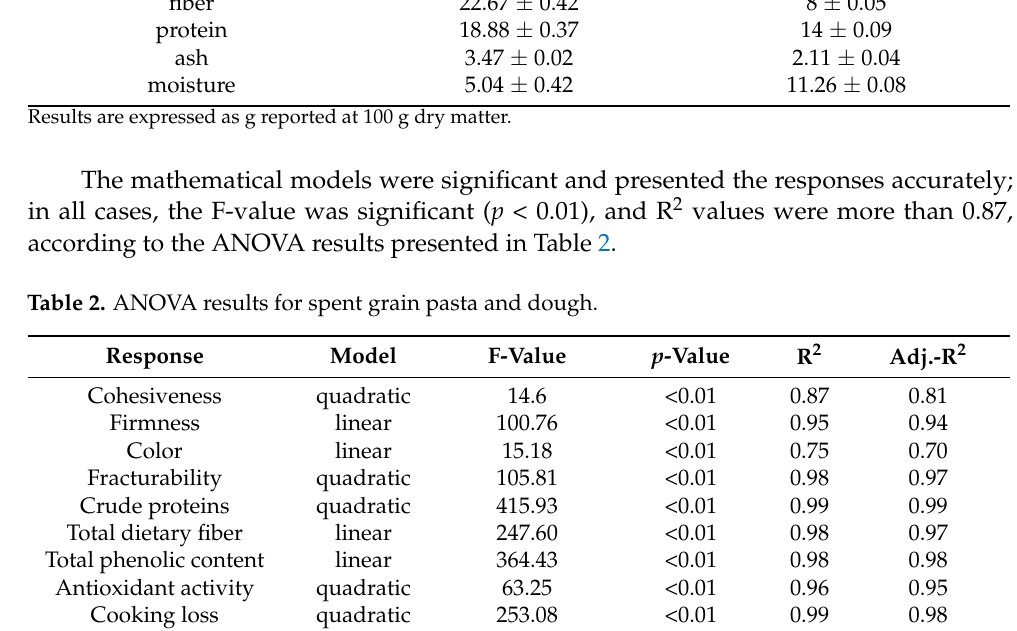
Table 1. Chemical composition of spent grain flour and spelt flour [39]. Chemical Composition